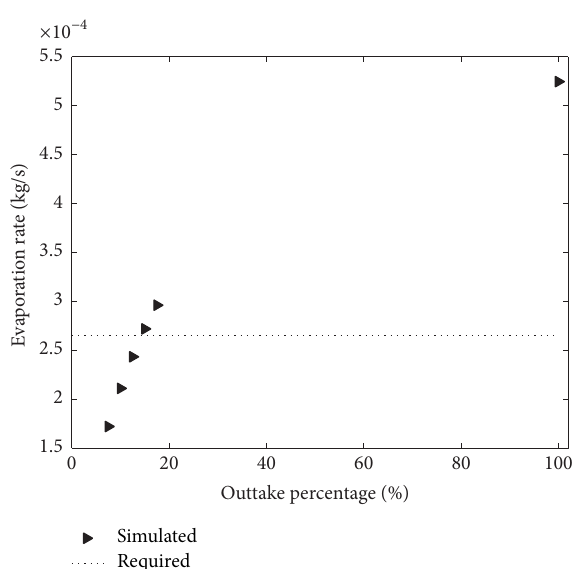
Figure 8: Area average evaporation rate as a function of OP.